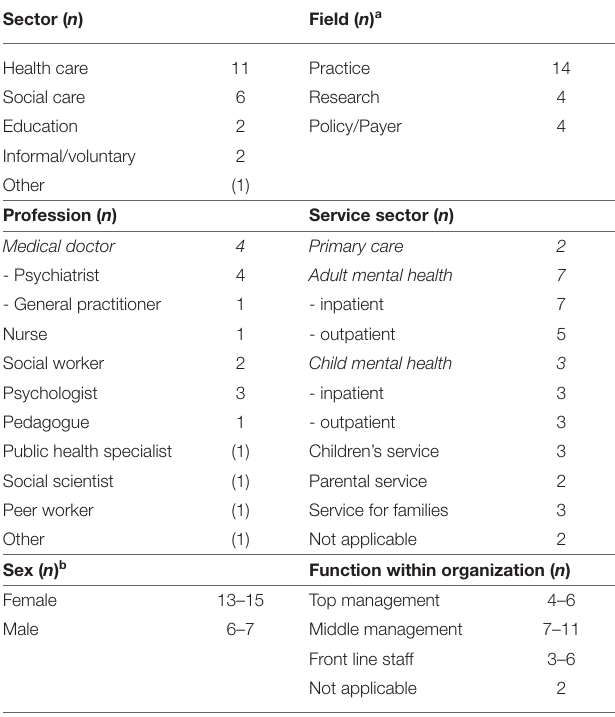
TABLE 1 | Characteristics of workshop